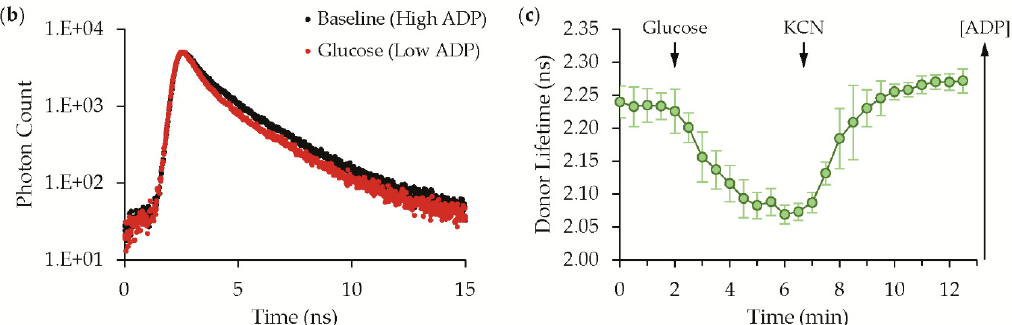
Figure 4. Live-cell assays validate the sensor response is reversible. ( a ) The steady-state fluorescence emission spectra (435 nm excitation) of the best sensor identified from library screening exhibits a ratiometric change in the mTFP1 donor emission peak and mVenus acceptor-sensitized emission peak. FRET decreases when ADP increases. The spectra are normalized to the total integrated fluorescence, and an isosbestic point at 515 nm is evident. In the live-cell assay, an increase in ADP is caused by metabolic inhibition of E. coli with cyanide (KCN). ( b , c ) When starved cells are fed glucose, the mTFP1 donor fluorescence lifetime decreases as expected because ADP is consumed. The sensor response is reversible, and the mTFP1 donor lifetime increases upon cyanide treatment, which causes a subsequent increase in ADP. Examples of raw fluorescence lifetime decays are shown in ( b ) and the time course of lifetime changes (mean ± 95%CI, n = 6) is shown in ( c ).